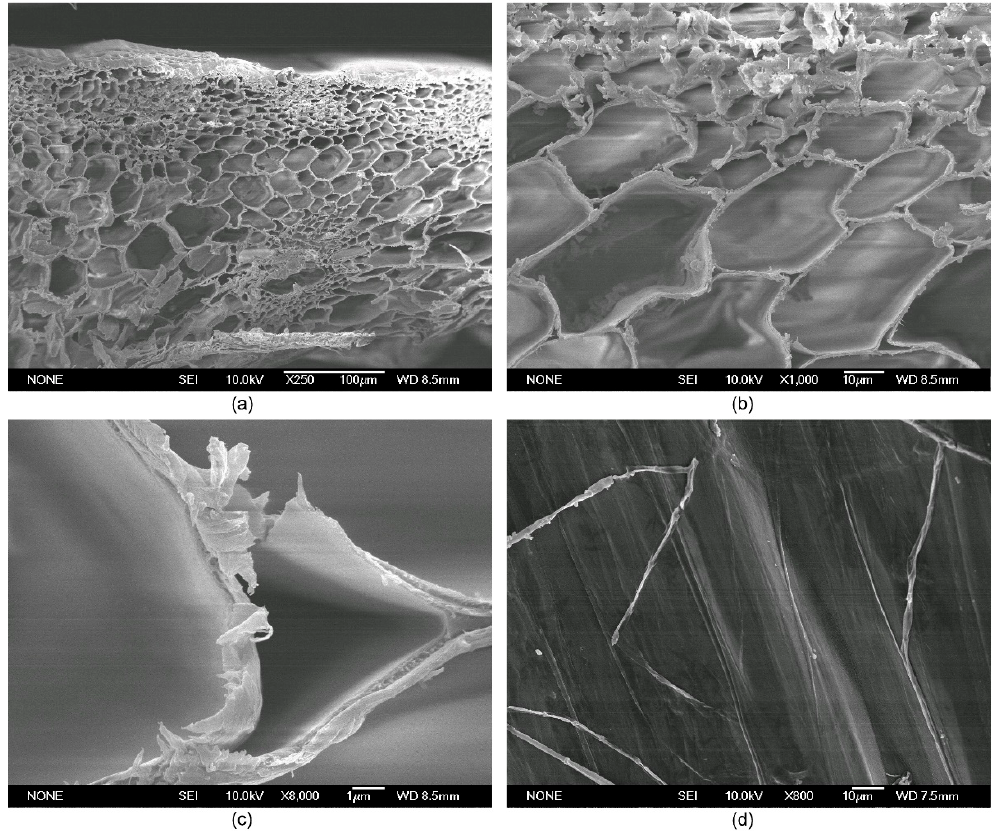
Figure 7. SEM micrographs of the wheat straw fiber’s honeycomb pattern (( a ) magnification of 250×; ( b ) magnification of 1000×; and ( c ) magnification of 8000×) and the wheat straw fiber surface (( d ) magnification of 800×).